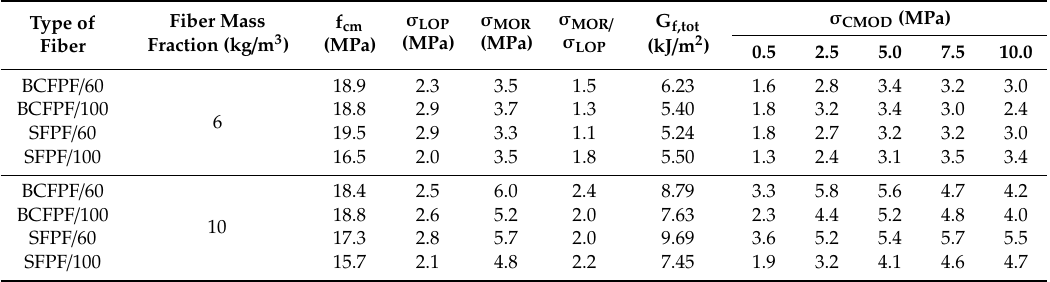
Table 7. Mechanical parameters of fiber-reinforced soil-cement with 400 / 0.8 matrix after 28 days of